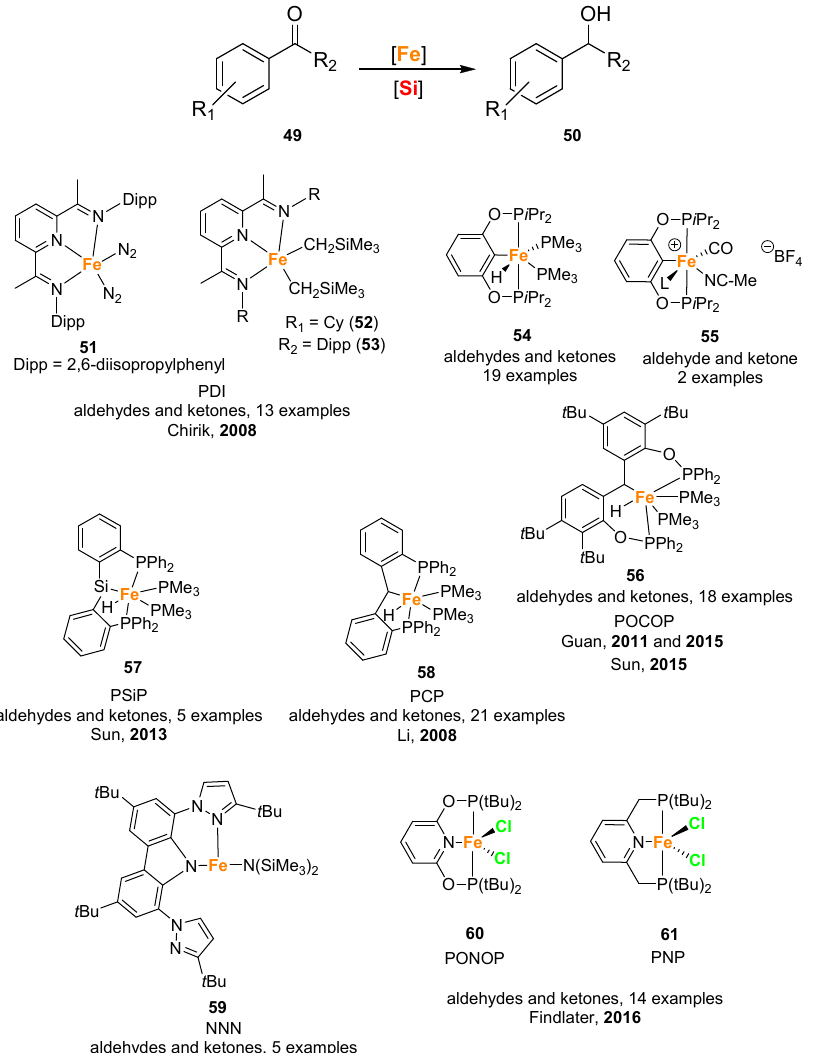
achieved with ( 54 ). However, the reduction of ketones varied according to the functional groups. For instance, electron neutral substrate could be reduced within 4.5 h, the electron-withdrawing group substrate could be reduced within 9 h, and the electron-donating group took 48 h. Moreover, no reaction was observed in the presence of sterics. ( 55 ) was sluggish in the hydrosilylation of aldehydes and ketones; both reactions took 24–48 h for quantitative conversion. The combination of PSiP ( 57 ) [163], PCP ( 58 ) [164] and POCOP ( 56 ) [165] iron hydride complexes were reported by Li and Sun, respectively; they were also found to e ff ectively reduce aldehydes and ketones with (EtO) 3 SiH as the silylating reagent. Very recently, Lee and co-workers reported an NNN pincer ligand-based iron (II) complex − 1 ( 59 ) with TOF up to 11 min (Scheme 10) [166].